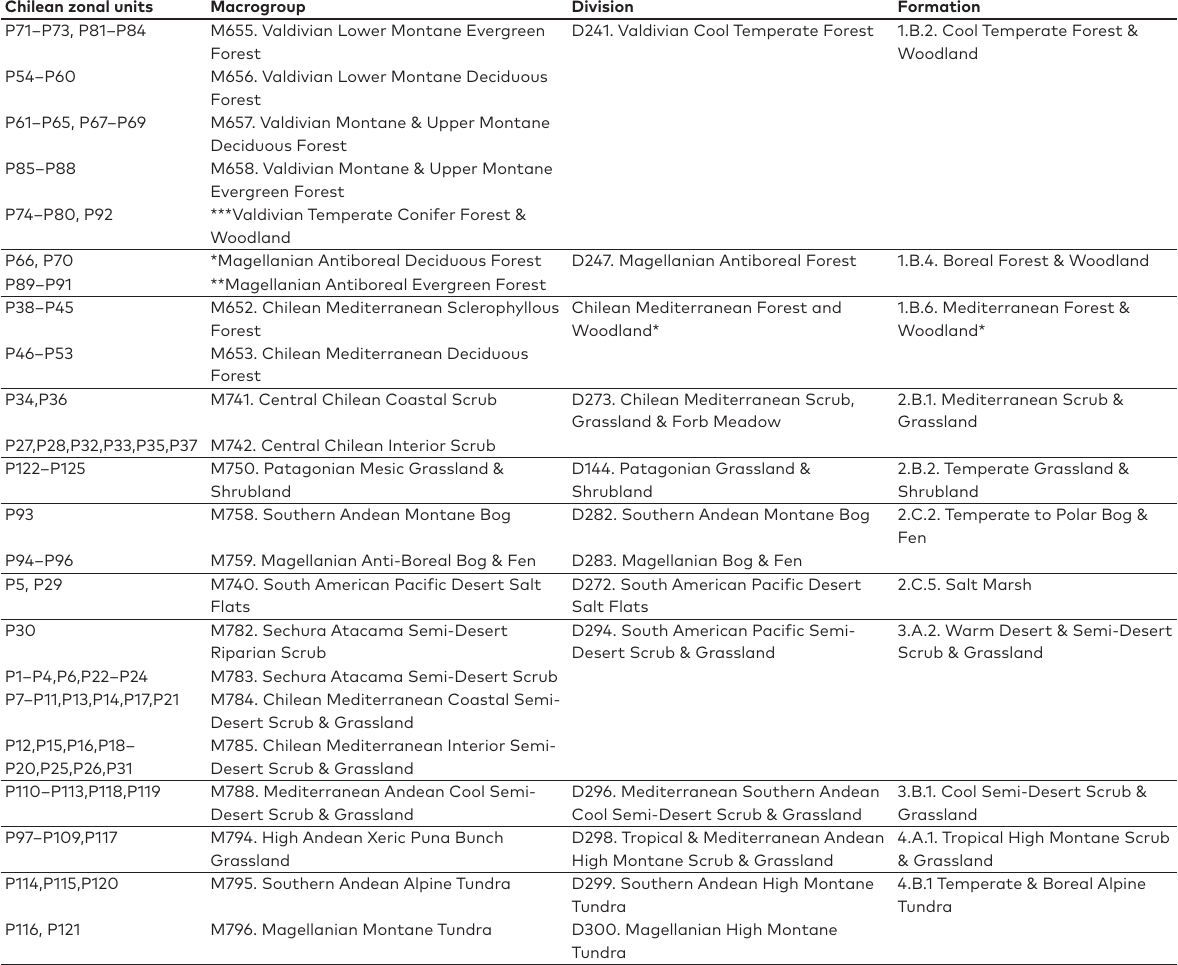
Table 1. Formations, divisions and macrogroups represented in the Chilean zonal vegetation. The left-hand column indi- cates the assignment of zonal units of Luebert and Pliscoff (2017) to each macrogroup. Macrogroup codes with asterisks indicate new macrogroups proposed here (different numbers of asterisks code distinguish newly proposed macrogroups for a clear link to Table A1). Division 1.B.6. is also indicated with an asterisk, because it is a new division proposed here. A full list of Chilean zonal units is given in Table